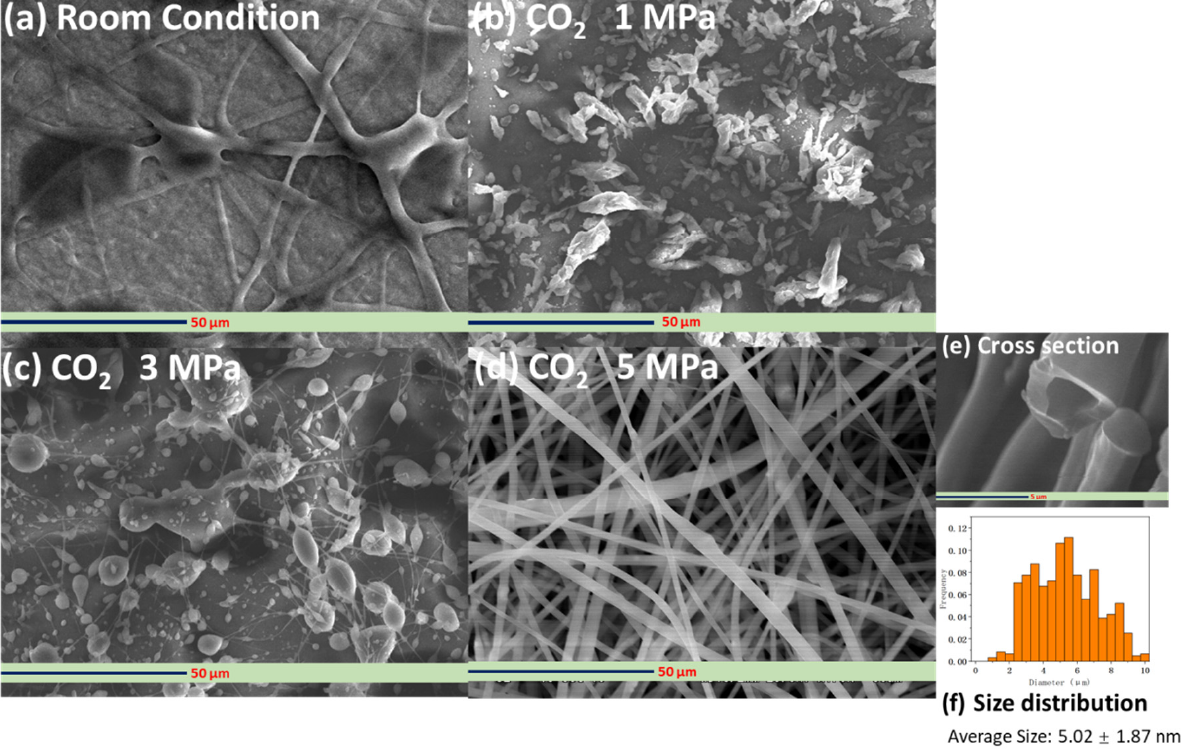
Figure 8. SEM images of the hollow PVP fibers fabricated from PVP solution containing Ag NPs under various CO2 conditions (room conditions, and 1, 3, and 5 MPa), ( a ) Room condition; ( b ) CO 2 1MPa; ( c ) CO 2 3MPa; ( d ) CO 2 5MPa; ( e ) cross section; ( f ) size distribution 1MPa; ( c ) CO 2 3MPa; ( d ) CO 2 5MPa; ( e ) cross section; ( f ) size